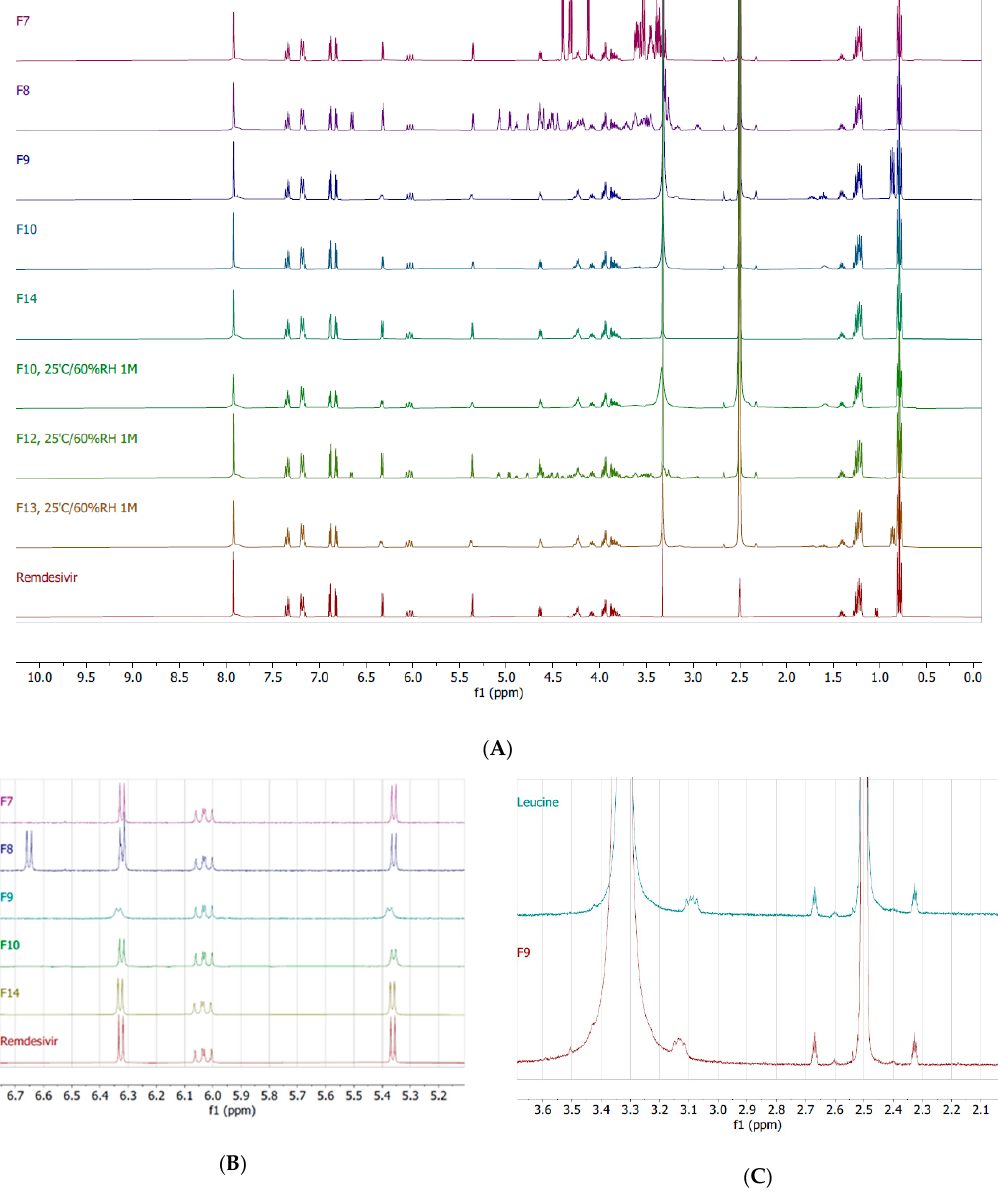
Figure 5. 1 H-NMR spectra; ( A ) TFF remdesivir powder formulations (F7, F8, F9, F10, F14) at initial condition, TFF remdesivir powder formulations (F10, F12, F13) at 25 ◦ C / 60% RH at 1 month, andremdesivirunprocessedpowder(remdesivir); ( B )expansionofTFFremdesivirpowderformulations (F7, F8, F9, F10, F14) and remdesivir unprocessed powder (remdesivir); ( C ) expansion of TFF remdesivir powder (F9) and leucine unprocessed powder